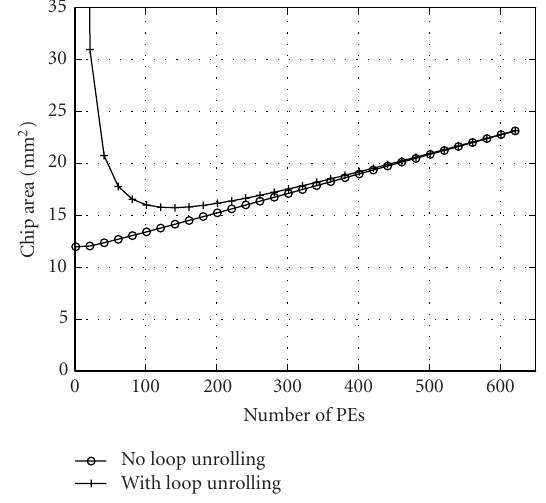
Figure 9: SIMD area scaling based on a 0.18 µ m design data.